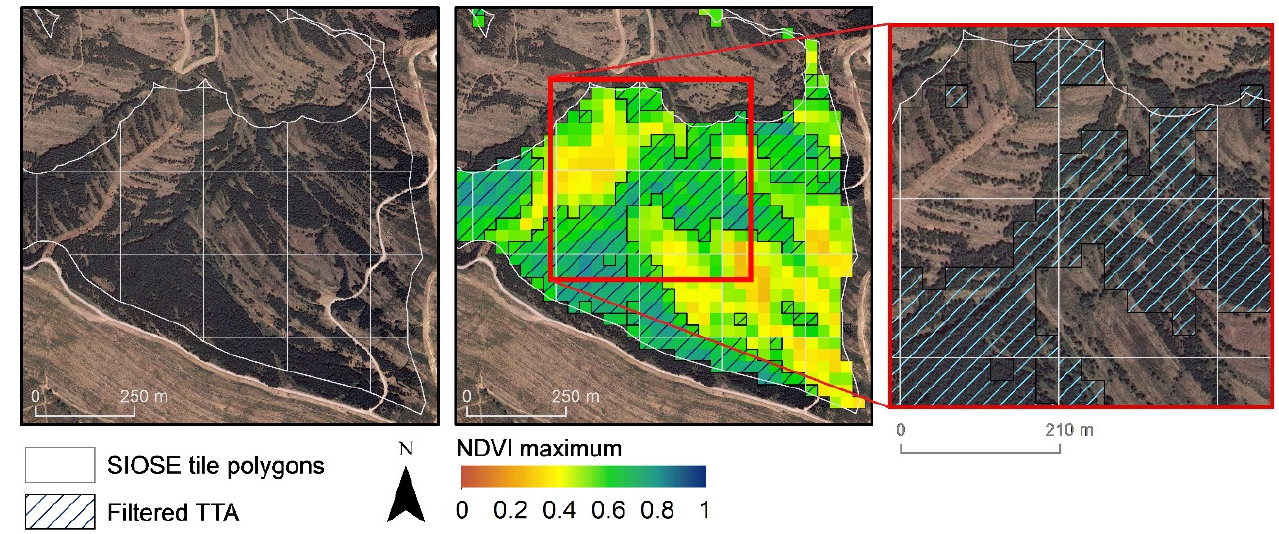
Figure 12. Rules 1 and 2 applied over a composite land cover polygon.